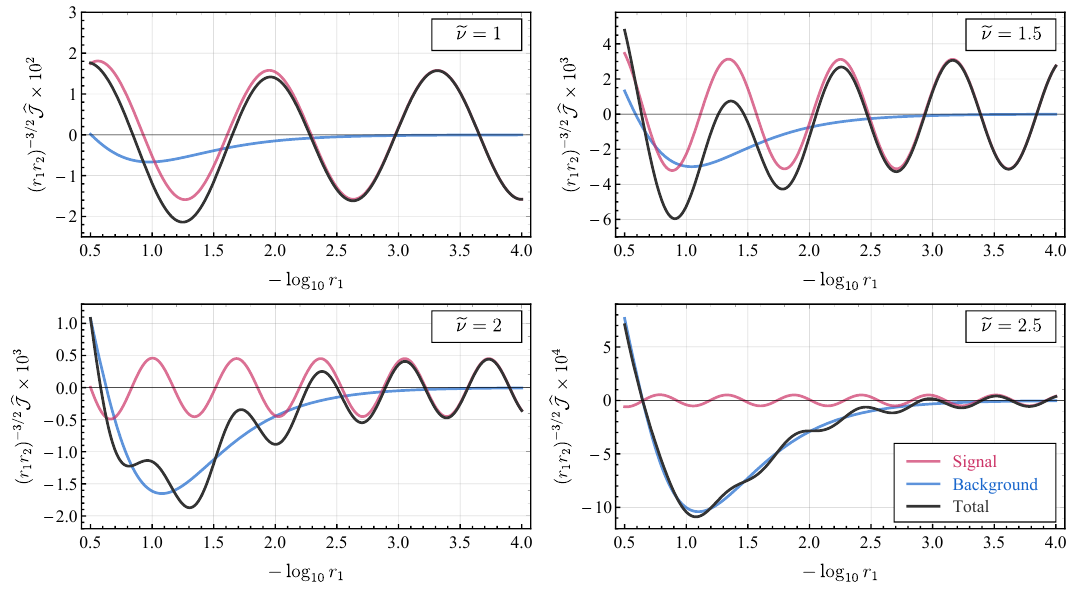
ν . The e + b J , the background b J , and the total result NS LS BG = νH . R e